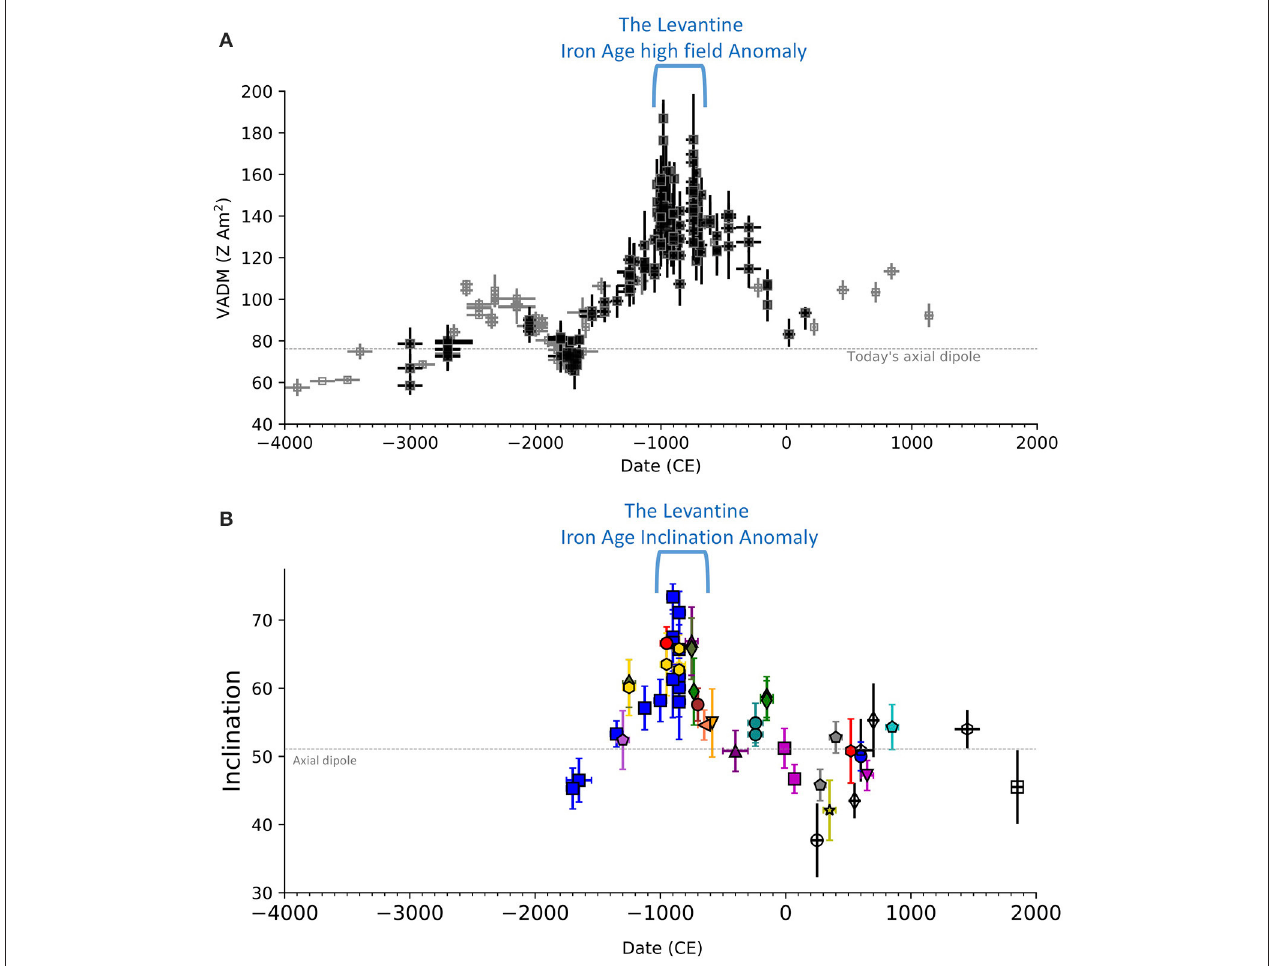
FIGURE 5 | The Levantine Iron Age anomaly. (A) Archaeointensity data from the Levant. Data from Israel, Jordan, and Cyprus [compilation of (Shaar et al., 2016) with data of ( Ben-Yosef et al., 2017)] are shown in black, and data from Syria are shown in gray (for references list see Shaar et al., 2016). (B) Inclination profile from this study, showing that the highest inclinations occur during the Levantine Iron Age anomaly, supporting the hypothesis of a local non-dipolar